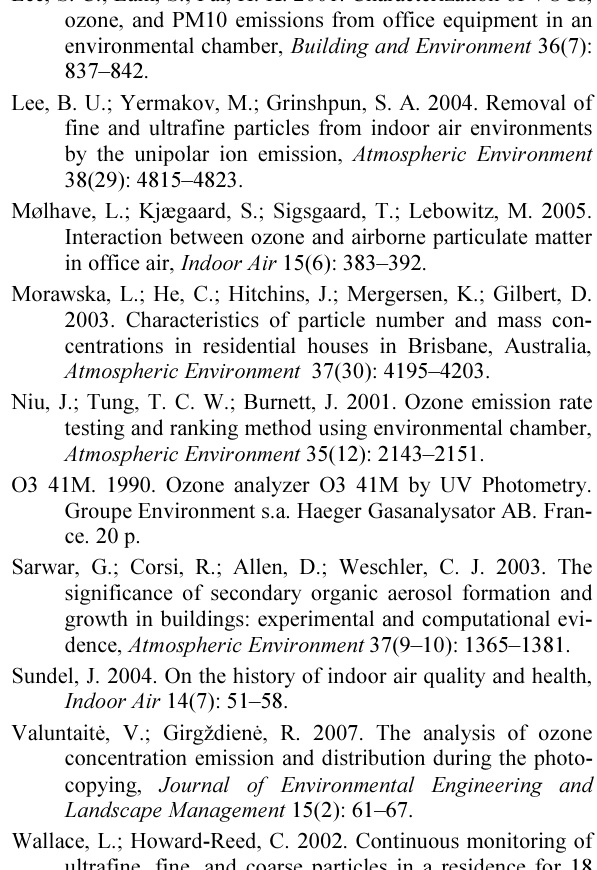
Fig. 9. Relationship between aerosol particles of different size and ozone